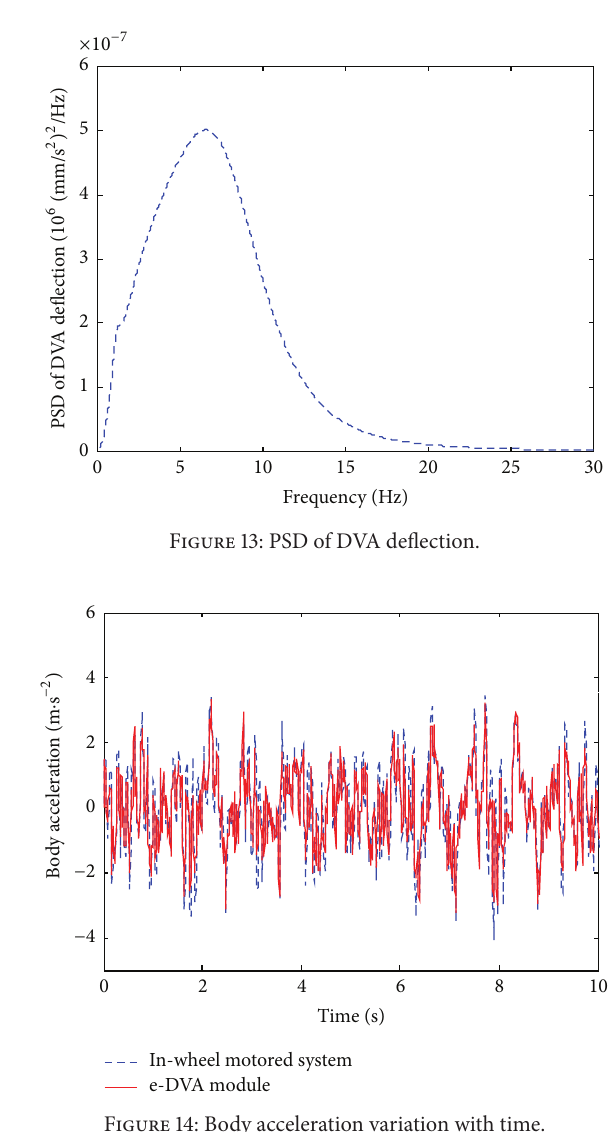
Figure 14: Body acceleration variation with